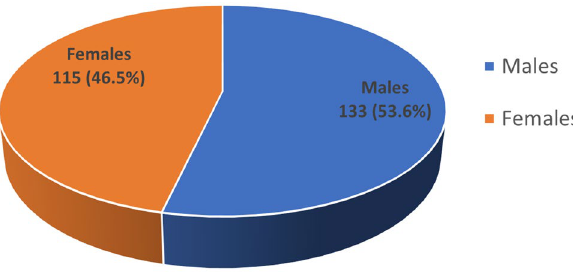
Figure 5. Pie chart of sex distribution of